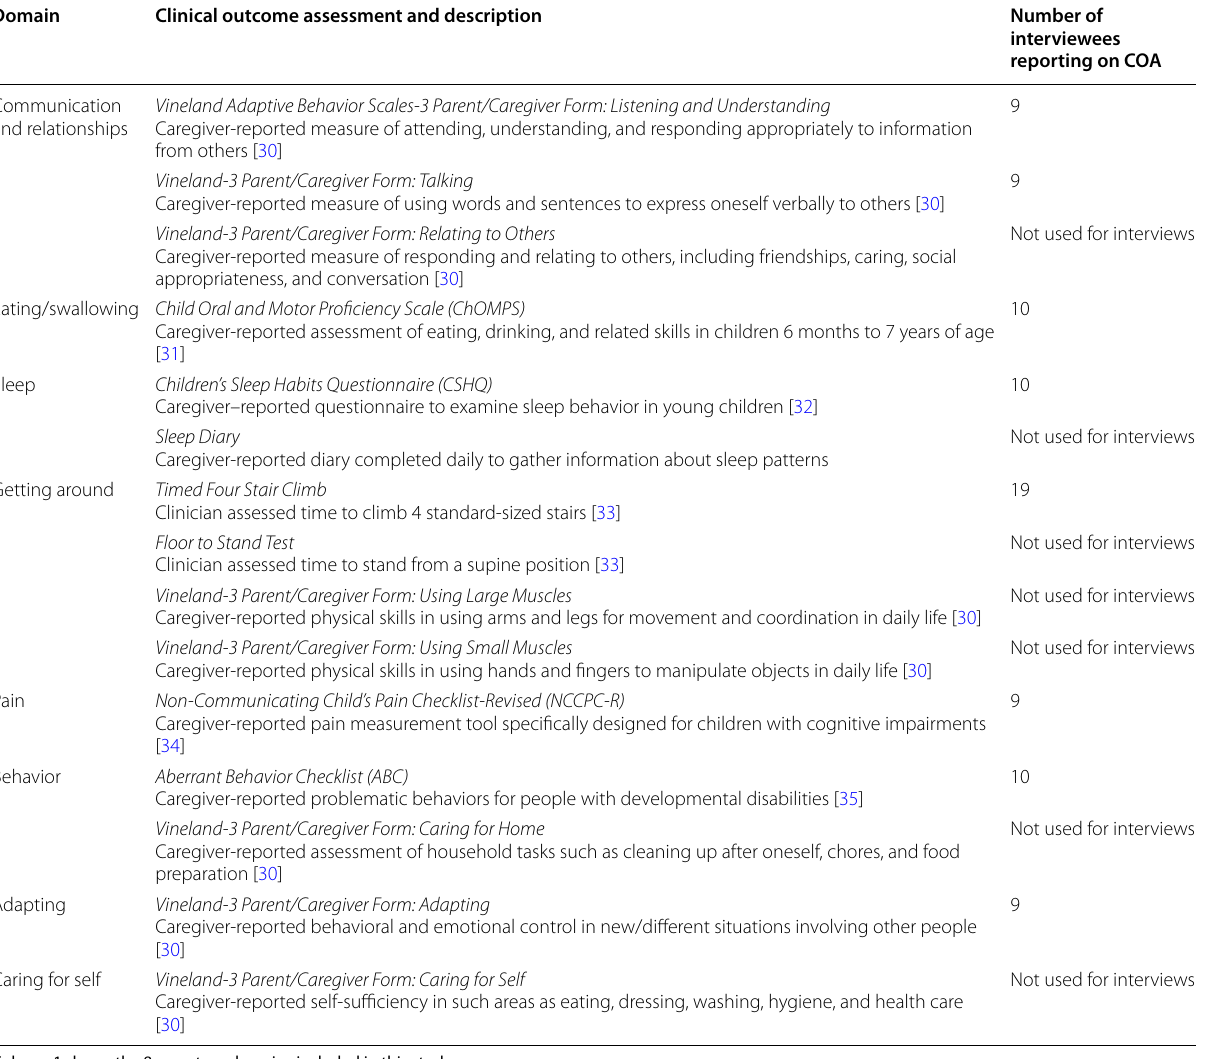
Table 1 Prioritized symptom domains and related clinical outcome